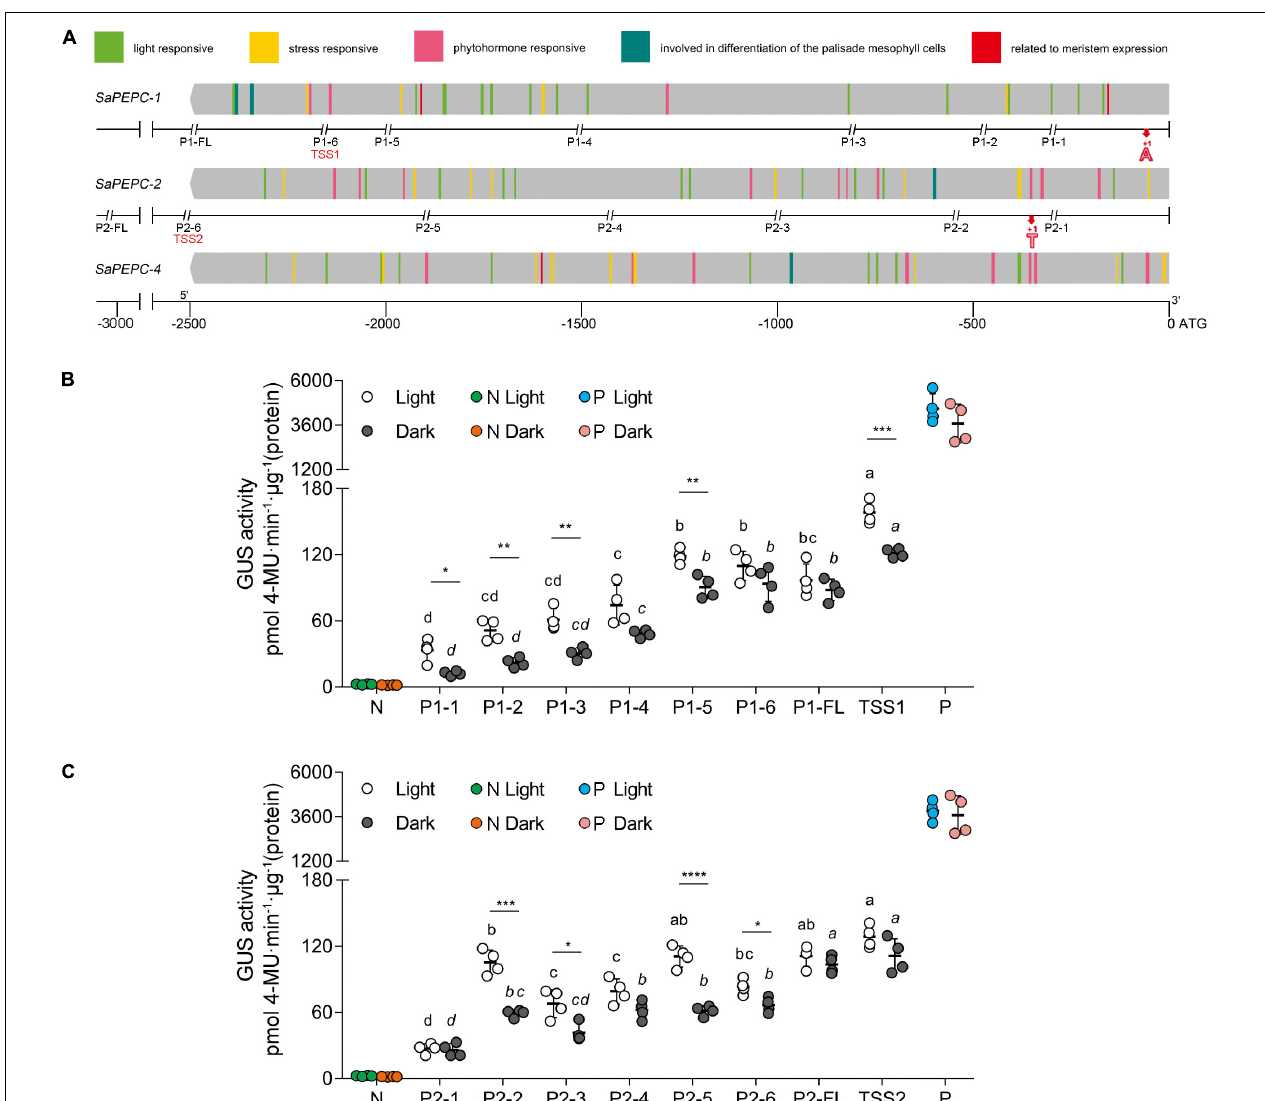
FIGURE 4 | Sequence and activity analysis of SaPEPC promoters. (A) Predicted cis -elements on promoters of three SaPEPC genes and a schematic diagram of truncated sites of two SaPEPC promoters; (B) β -glucuronidase (GUS) enzyme activity driven by SaPEPC-1 promoter; (C) GUS enzyme activity driven by SaPEPC-2 promoter. The promoter regions (2,500 bp) of three SaPEPC genes were analyzed, and different cis -elements were present in color boxes. The numbers at the bottom of figure (A) indicate the distance to the start codon ATG. P1 and P2 represent SaPEPC-1 and SaPEPC-2 promoter, respectively. FL represents a full-length sequence from ATG of each promoter, which was consequently truncated into six fragments. The double italic slash represents the truncated site; the numbers 1–6 represent different truncated fragments ranking from the smallest to the largest. The red bold “A” (+1) and “T” (+1) marked the transcription start sites (TSSs), TSS1 and TSS2 represent a upstream sequence from TSSs of SaPEPC-1 and SaPEPC-2 promoters, respectively. N, negative control, injected with A. tumefaciens EHA105; P, positive control, injected with A. tumefaciens EHA105 harboring with pBI121 plasmid. Different lowercase letters indicate a significant difference between different fragments; *, **, ***, ****: Represent a significant difference between light and dark treatments of the same fragment at 0.05, 0.01, 0.001, 0.0001 level,